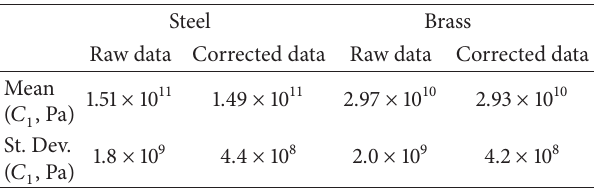
Table 1: Mean value and standard deviation of 𝐶 1 obtained from individual fitting of the curves before and after data correction on steel and brass calibration blocks. The standard deviation of the curves is reduced by a factor of 3.9 for steel and 4.7 for